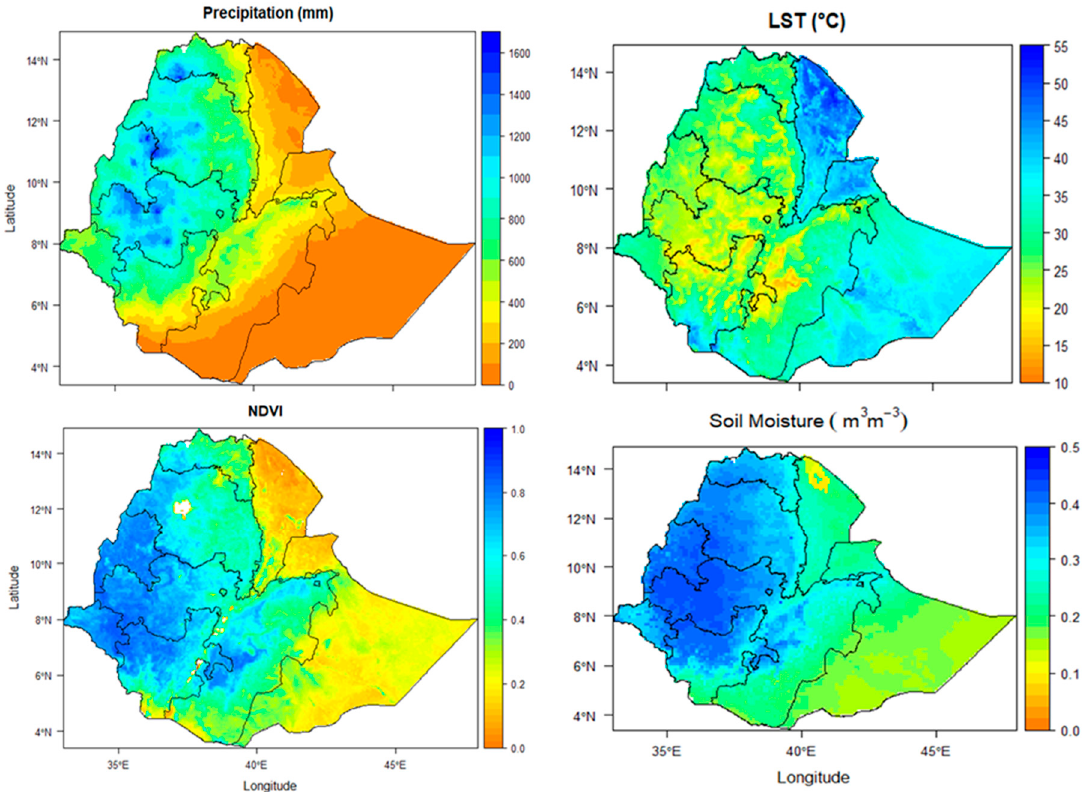
Figure 2. Long-term seasonal average of rainfall (mm), land surface temperature (LST, ◦ C), normalized di ff erence vegetation index (NDVI), and soil moisture (m 3 m − 3 ) for the period from 2001 to 2018.